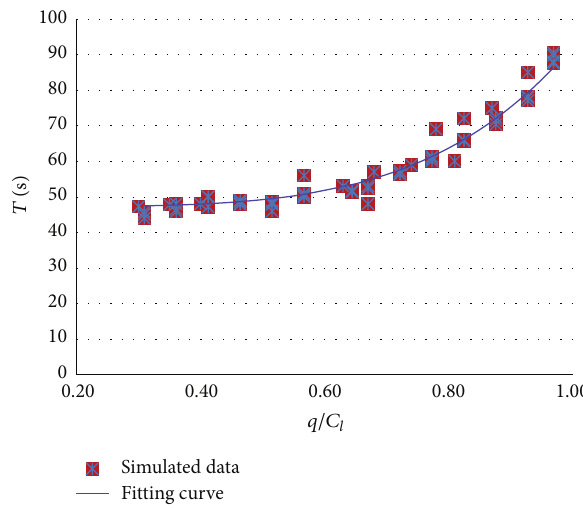
Figure 1: Relationship between the travel time of car and 𝑞/𝐶 𝑙 on the segment.